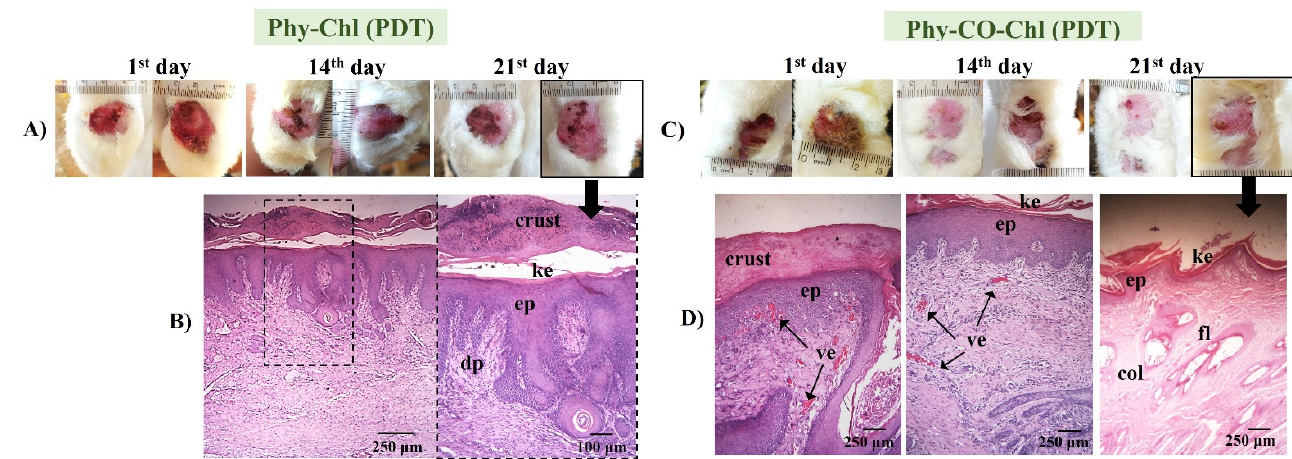
Figure 14. ( A , C ) Macroscopical aspects of the plantar face of feet in rabbits during Phy-Chl and Phy-